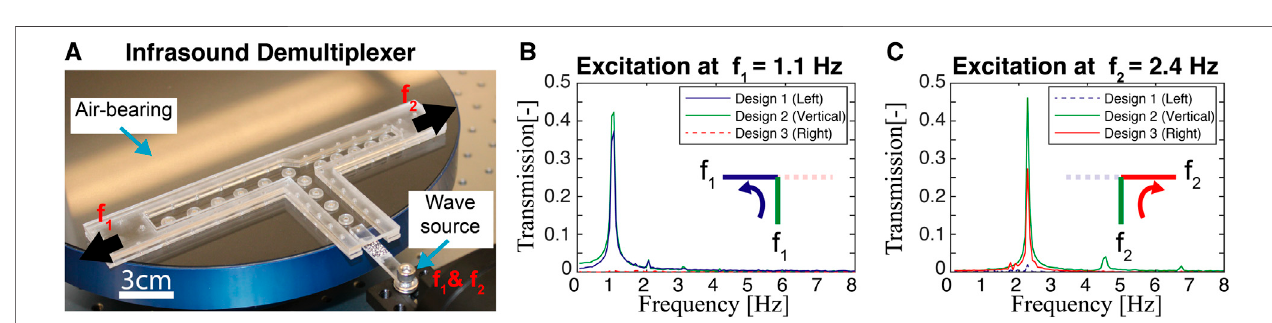
FIGURE 5 | Infrasound demultiplexer. (A) The experimental setup for the T-shaped demultiplexer positioned on an air bearing. The demultiplexer is fi lled with identical meta-atoms con fi ned between different magnetic boundaries. A mechanical shaker drives the input channel through an arm with an embedded magnet. The signal transmission at (B) f 1 (cid:2) 1 . 1 Hz and C) f 2 (cid:2) 2 . 4